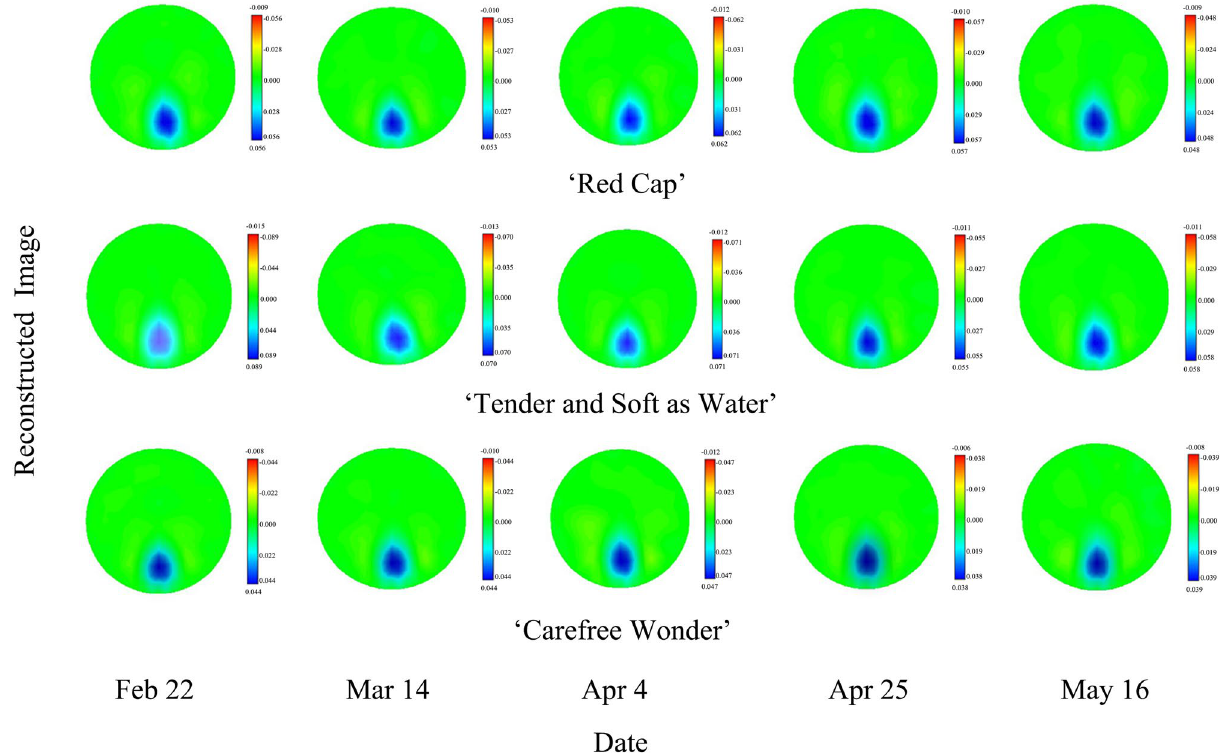
Figure 1. Electrical impedance tomography (EIT) images of the stems of three floribunda rose ( Rosa hybrida) cultivars during the dehardening